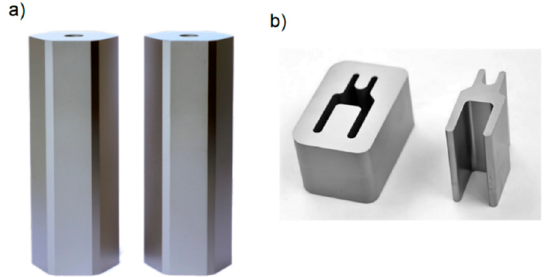
Figure 1. Profiles of the fine-blanking punches. ( a ) hexagonal punch, ( b ) “H-shaped” punch. Source of the picture: Feintool Technologie AG.